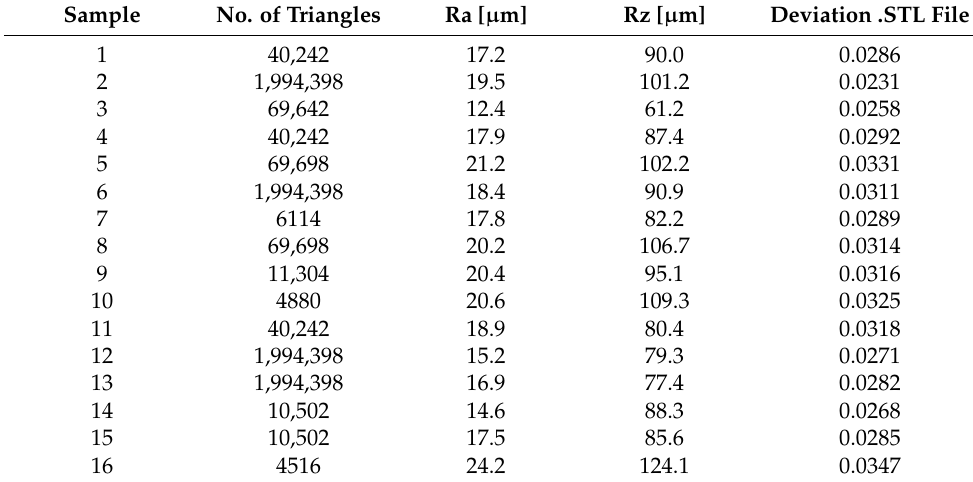
Table 3. Surface roughness and deviation [97].